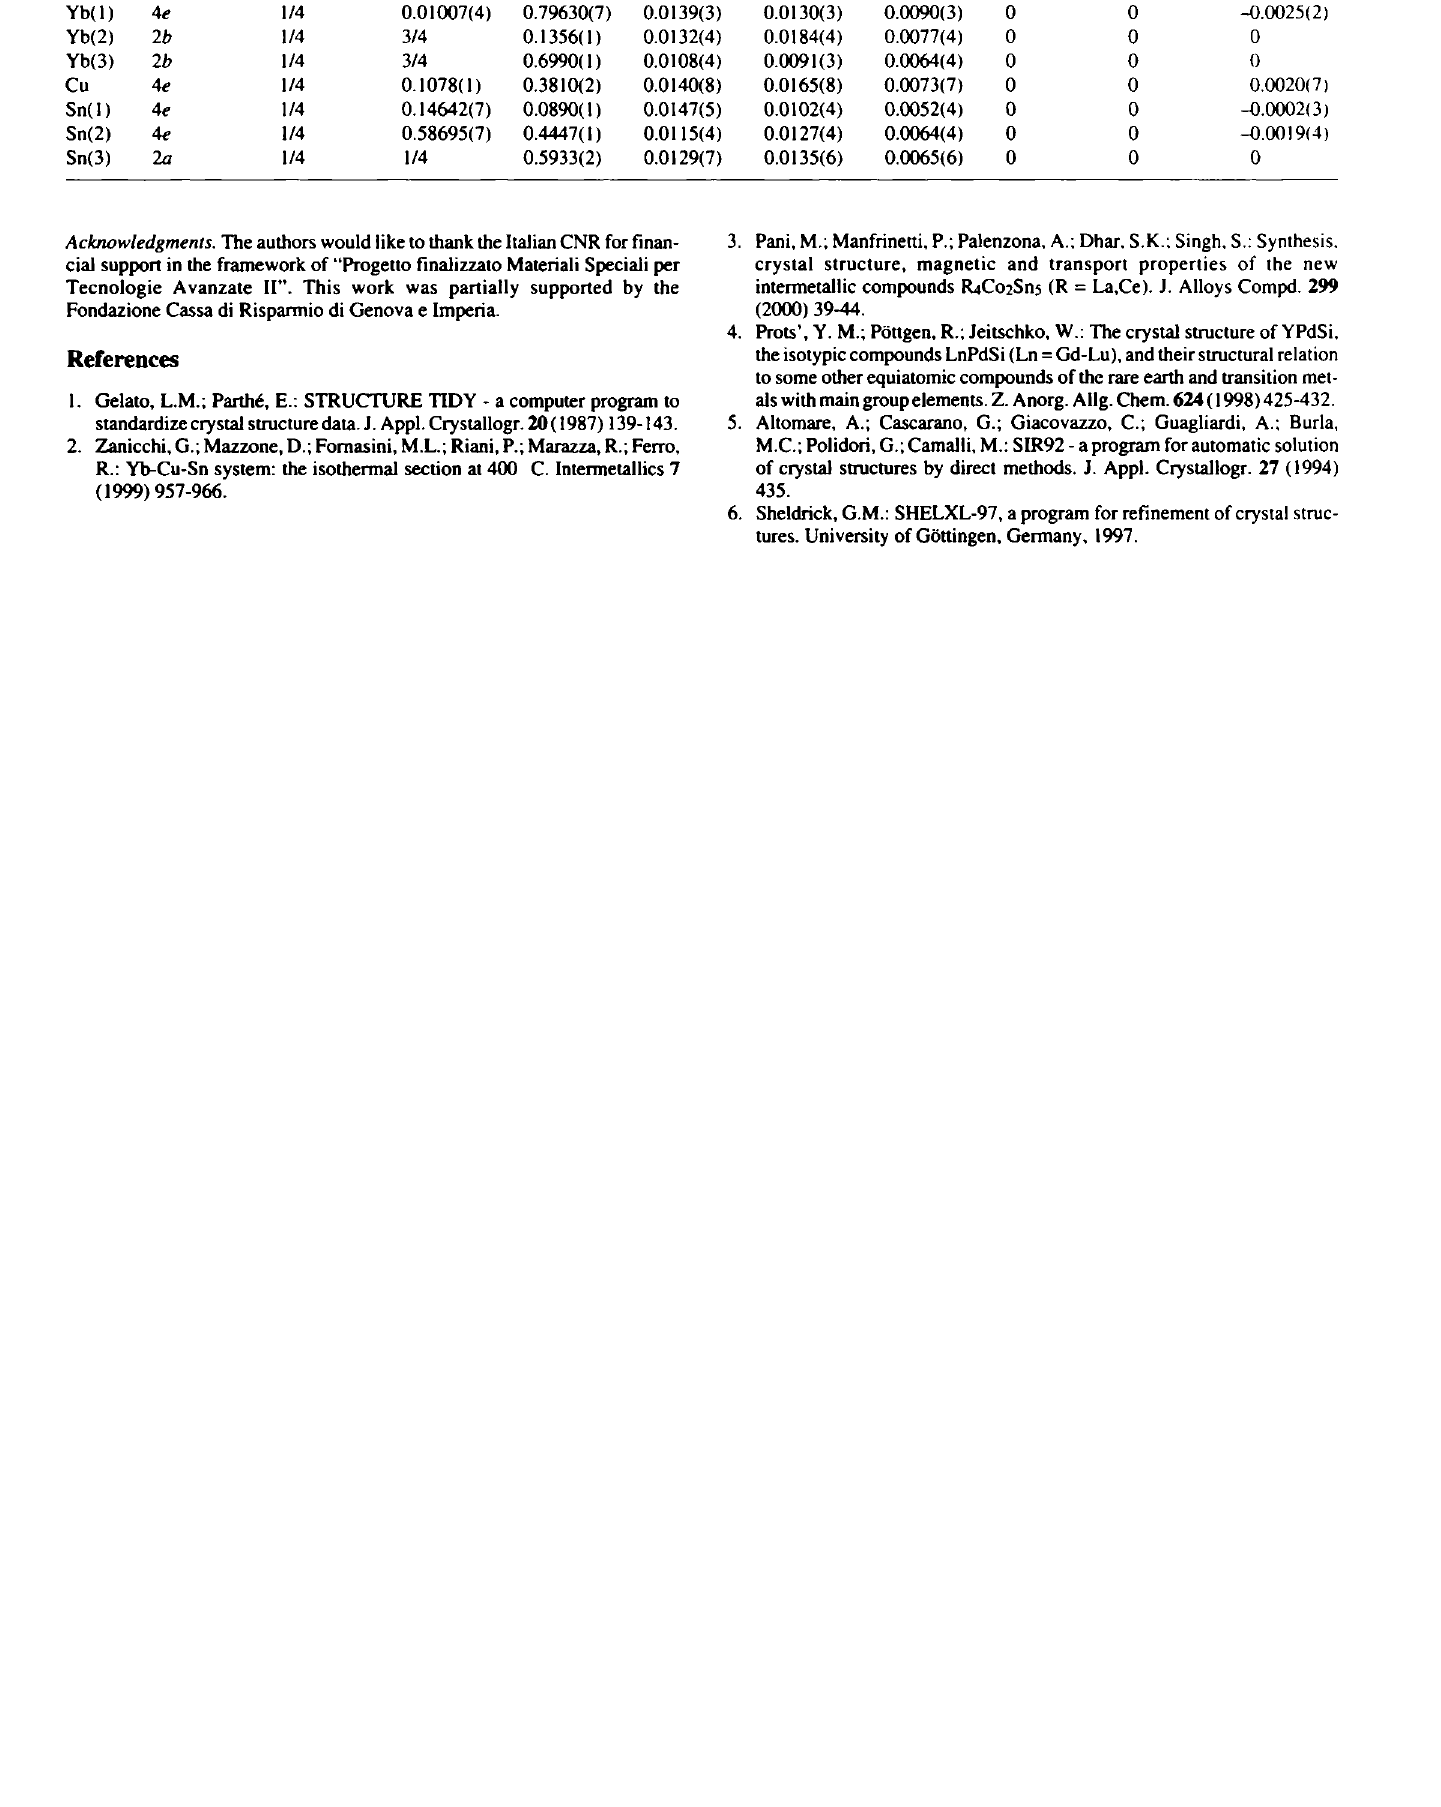
Table 2. Atomic coordinates and displacement parameters (in Ä 2